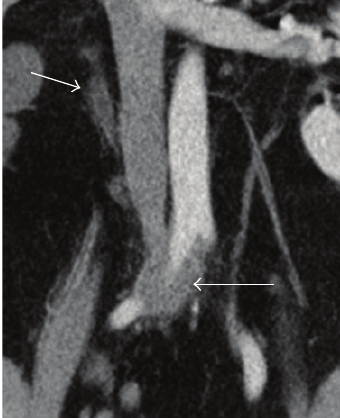
Figure2:CATscancoronalviewshowsmuralsegmentalthickening in common iliac artery (large arrow) and hydroureter (small arrow).